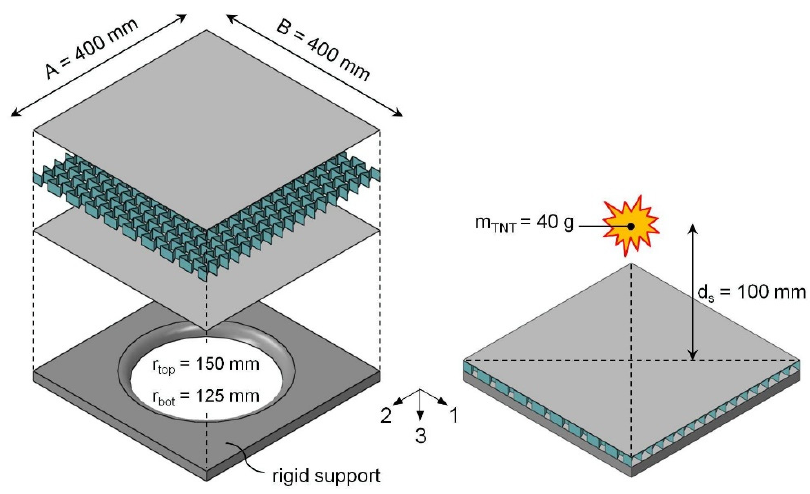
Figure 13. Configuration of the numerical model, including the support structure and the load source (air blast).